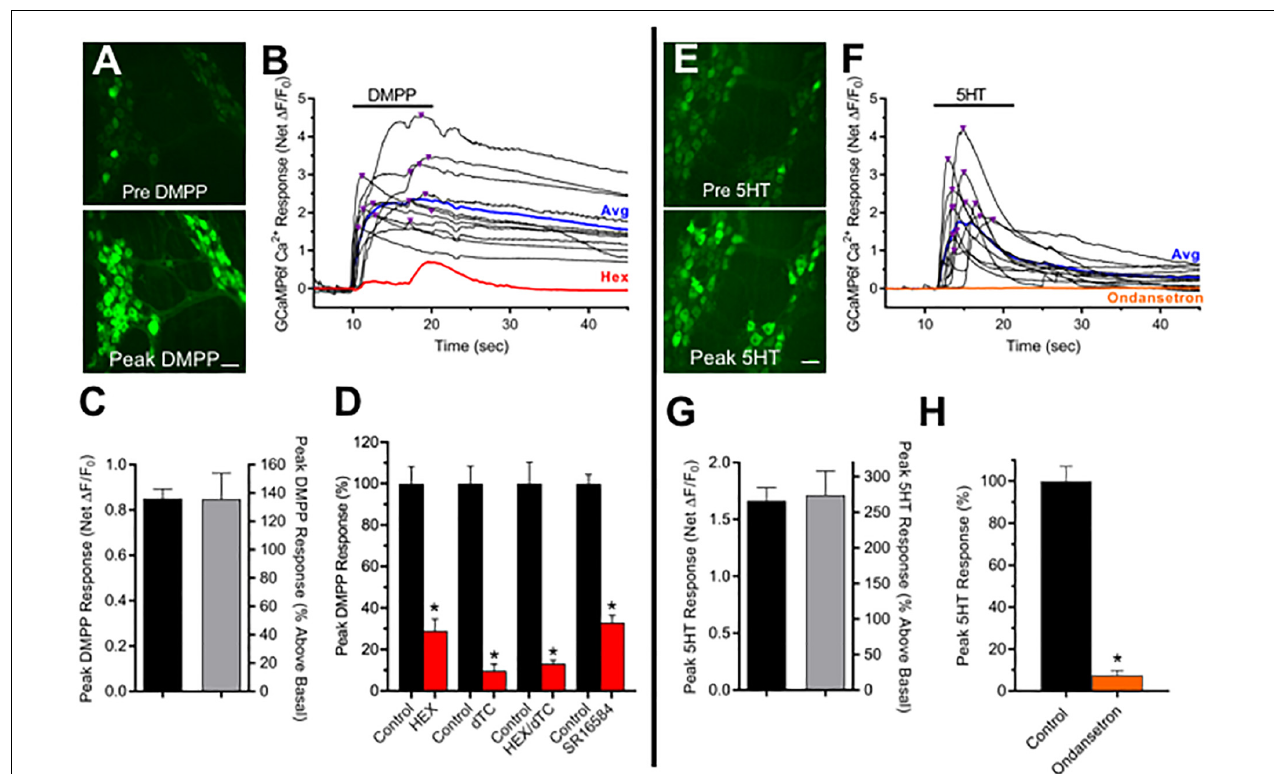
FIGURE 1 | Most cholinergic MG neurons express functional nAChRs and 5-HT 3 Rs. (A–D) nAChRs. (A) Panels depict neuronal GCaMP6f Ca 2 + fluorescence increases from basal levels (top panel) to peak levels (bottom panel) associated with DMPP application. Panels depict two MG, each containing several GCaMP6f + /ChAT + neurons. Scale bar at bottom represents 40 µ m. (B) Time course of Ca 2 + fluorescence changes in 13 of the neuron somas depicted in A black traces) in response to focally applied DMPP (black bar; 20 µ M, 20 psi). Inverted triangles above the traces depict the timing of net peak (cid:49) F/F 0 responses (A A , Peak ). The response average from these neurons and that of the same neurons after incubation with hexamethonium (Hex, 100 µ M) are depicted by the blue and red traces, respectively. (C) Global summary of DMPP responses. A total of 69 ± 6% of cholinergic MG neurons tested from N = 15 explants responded to 10 µ M DMPP, doing so with an average net peak (cid:49) F/F 0 amplitude (A A , Peak ) of 0.85 ± 0.04 ( n = 321) representing a 135 ± 18% increase above basal (cid:49) F/F 0 . (D) Pharmacology of DMPP responses. Incubation with generic nAChR antagonists Hex (100 µ M), dTC (100 µ M) or their combination (Hex/dTC), or with SR16584 (40 µ M) an antagonist selective for α 3, β 4-containing nAChRs for 10–15 min reduced A A , Peak doing so, respectively, to 29 ± 6% ( n = 15), 10 ± 3% ( n = 15), or 13 ± 2% ( n = 29), or 33 ± 4% ( n = 75) of levels obtained from the same neurons before antagonist application (black bars, Control). (E–H) . 5-HT 3 Rs. The fields in (E) each depict two myenteric ganglia containing several GCaMP6f + /ChAT + neurons. Neuronal Ca 2 + fluorescence increases from basal levels (top) to high levels following exposure to 10 µ M 5-HT (bottom). Scale bar at bottom represents 40 µ m. (F) Time course of GCaMP6f Ca 2 + fluorescence responses to focally applied 5-HT (black bar, 10 µ M, 20 psi) in 13 of the neurons depicted in (A) (black traces). Inverted triangles above the traces depict the timing of A A , Peak . The response average from these neurons and that of the same neurons after incubation with Ondansetron (20 µ M; 10–15 min) are depicted by the blue and orange traces, respectively. (G) Global summary of 5-HT responses. A total of 62 ± 6% of cholinergic MG neurons tested from N = 3 explants responded to 5-HT, doing so with an average A A , Peak of 1.66 ± 0.12 ( n = 60) representing a 274 ± 34% increase above basal (cid:49) F/F 0 . (H) Pharmacology of 5-HT responses. Incubation with the